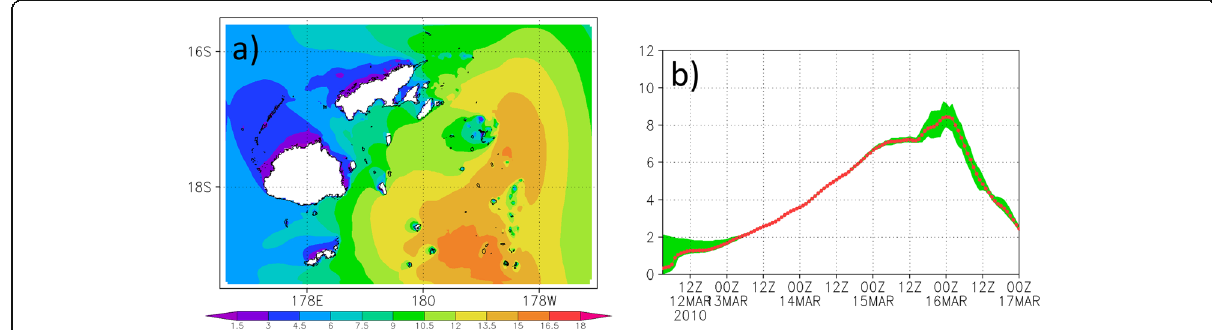
Fig. 8 WW3 simulation results. a Spatial distribution of the ensemble mean maximum significant wave height in the CTL. The unit of the color bar is m. b Temporal variation in the significant wave height over the offshore region of Suva in the CTL. The red line represents the ensemble mean value. Green shading indicates the range of the ensemble spread. The unit for the vertical axis is